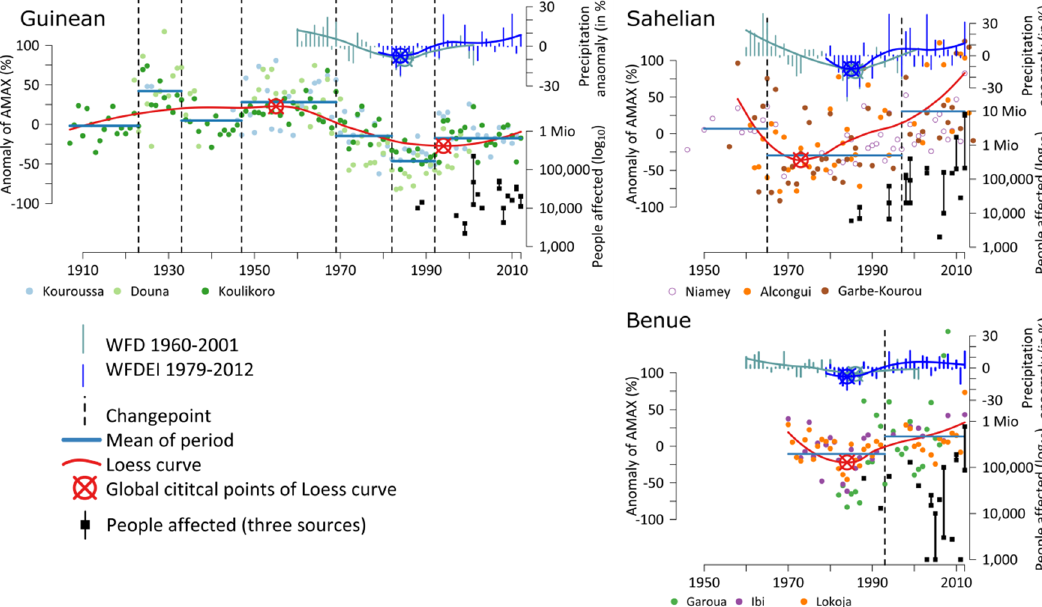
Figure 4. Top: Annual maximum discharge (AMAX), precipitation and people affected by floods in the NRB, separated for the three subregions. Detected changepoints for the mean AMAX in each region are plotted as black dashed lines. Note that for the Sahelian region the numbers of people affected by catastrophic floods are plotted for the whole Middle Niger (see Section 3.1.2). Please also note for the Sahelian region that only stations on the tributaries (Alcongui, Garbe-Korou) have been used for the Loess curve. The station Niamey has gaps where the red flood was covered by the Guinean flood in the hydrograph.